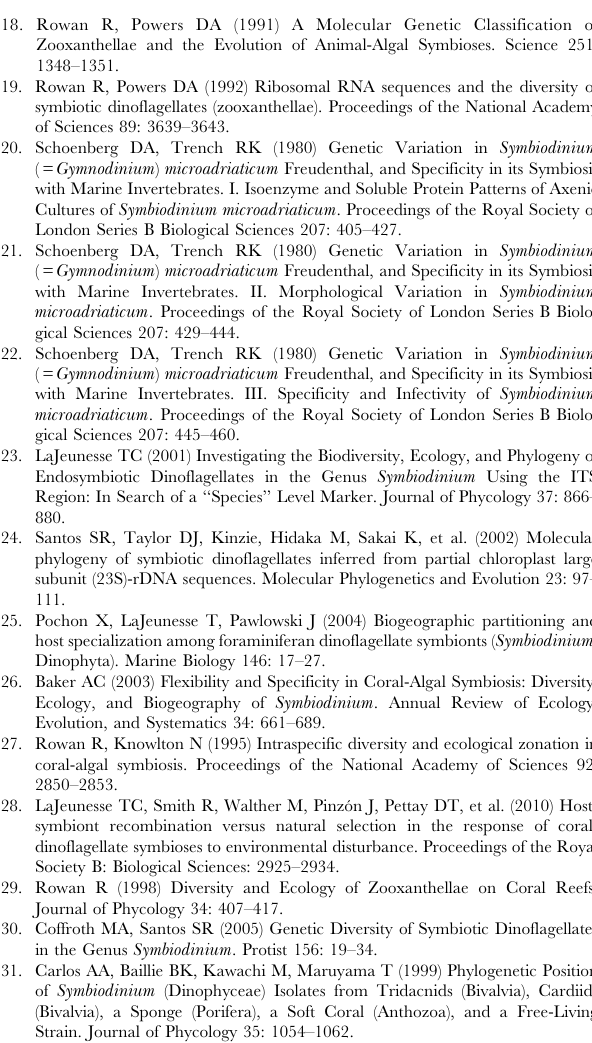
Table S1 Dinoflagellate taxa and GenBank